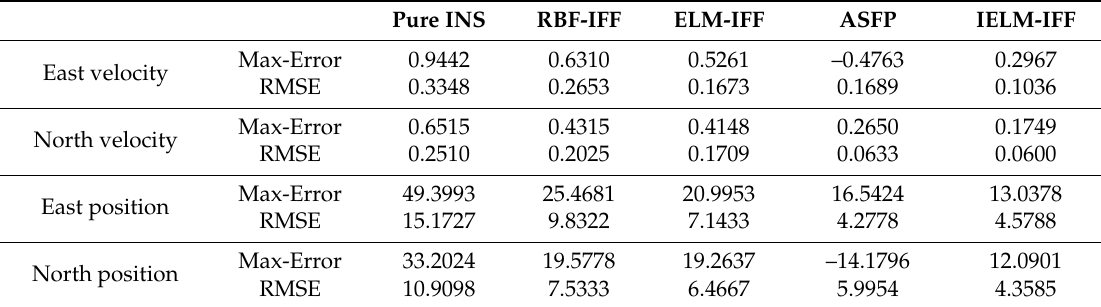
Figure 14. Curves of the east position error ( a ) and north position error ( b ) during GPS outages. Table 9. The RMSEs and maximum error values of the velocity (m/s) and position (m) for the different algorithms. ASFP: artificial-intelligence-based segmented forward predictor.